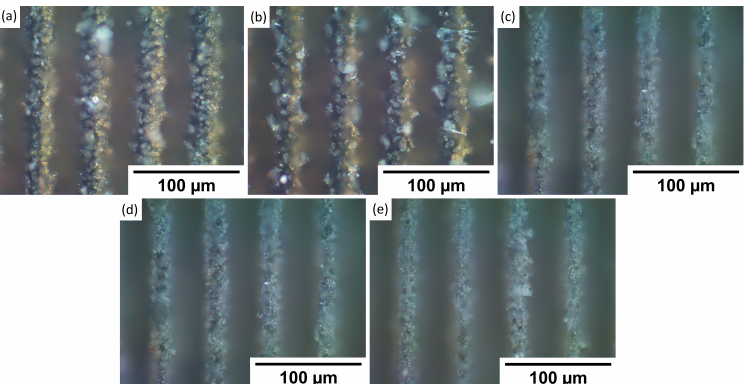
Figure 3. Microscope pictures, with × 100 magnification, of each sample LIPSS texture. ( a )—17- 4PH stainless steel, ( b )—PH13 stainless steel, ( c )—Ti6Al4V titanium, ( d )—2024 T3 aluminum, and ( e )—7050 aluminum.